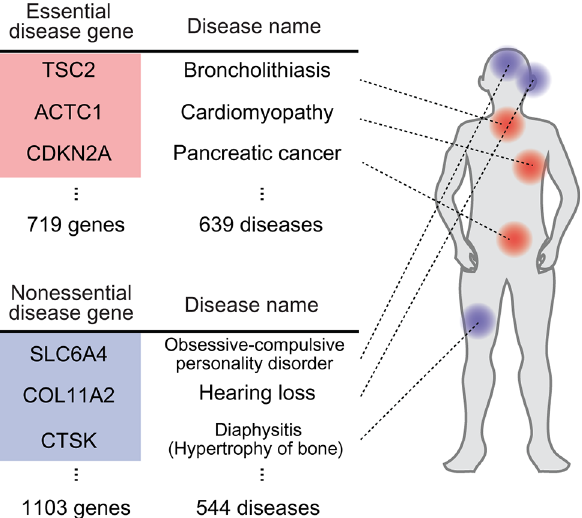
Fig 1. Gene essentiality and human disease genes. Mapping mouse essential and nonessential genes to human disease genes through gene orthologs.